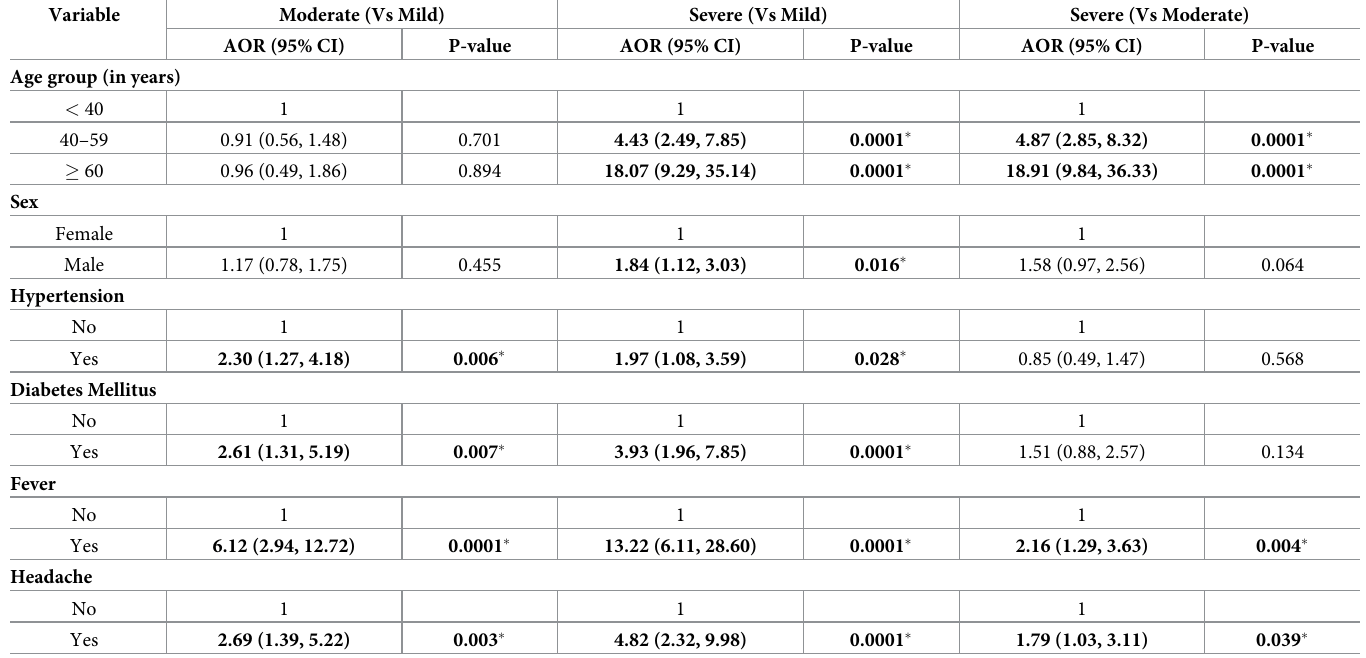
Table 3. Results for the final multinomial logistic regression model among COVID-19 patients (n = 686).